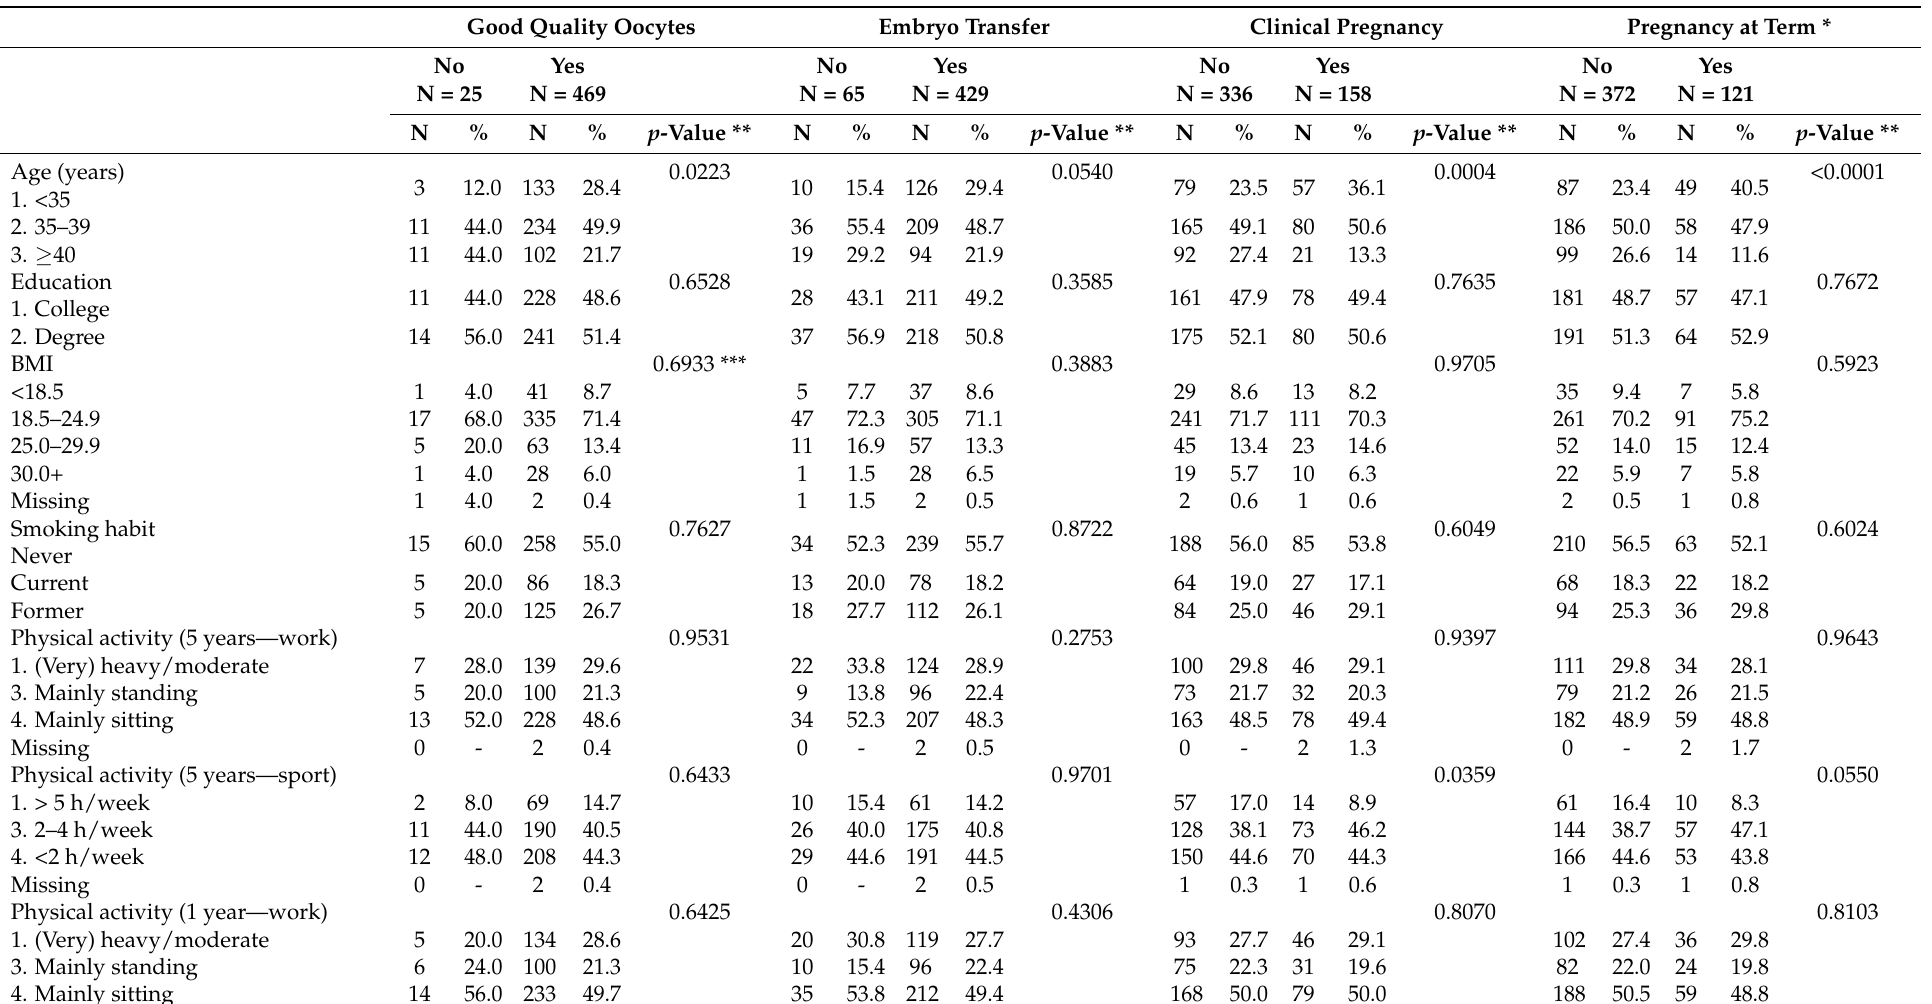
Table 1. Baseline characteristics by IVF